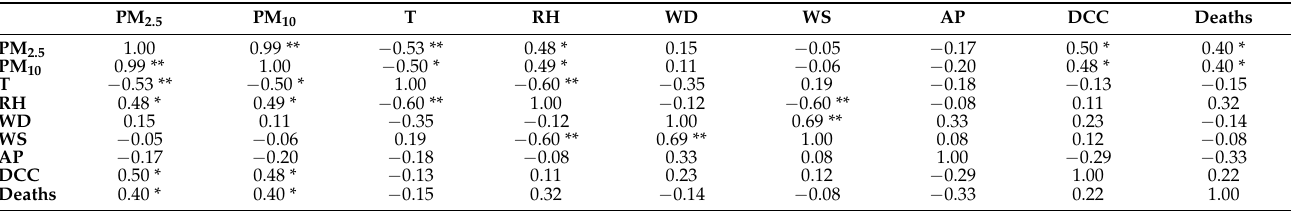
Table 5. Spearman correlation coefficient matrix using the indoor pollution and meteorological parameters